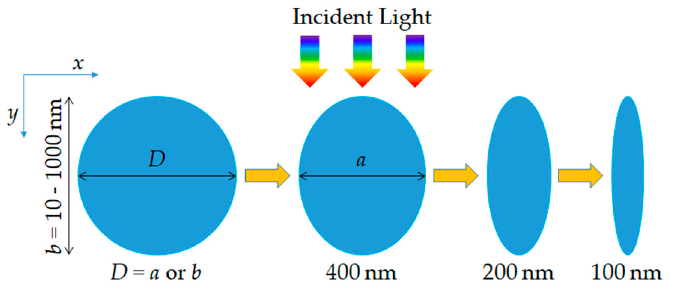
Figure 1. Schematics of the cross-section of a circle nanowire (CNW) and several elliptical nanowires (ENWs). The geometrical metrics used to describe the geometry of the ENWs, the horizontal ( x ) axis a and the vertical ( y ) axis b , are shown. Note here that three representative values of a are chosen to be 400, 200 and 100 nm, the range of b is from 10 to 1000 nm. The diameter D of the CNWs are chosen to be a or b for comparison, the material of the ENWs is set to be silicon as a representative semiconductor and the light illumination is perpendicular to the axis of the ENW from above.